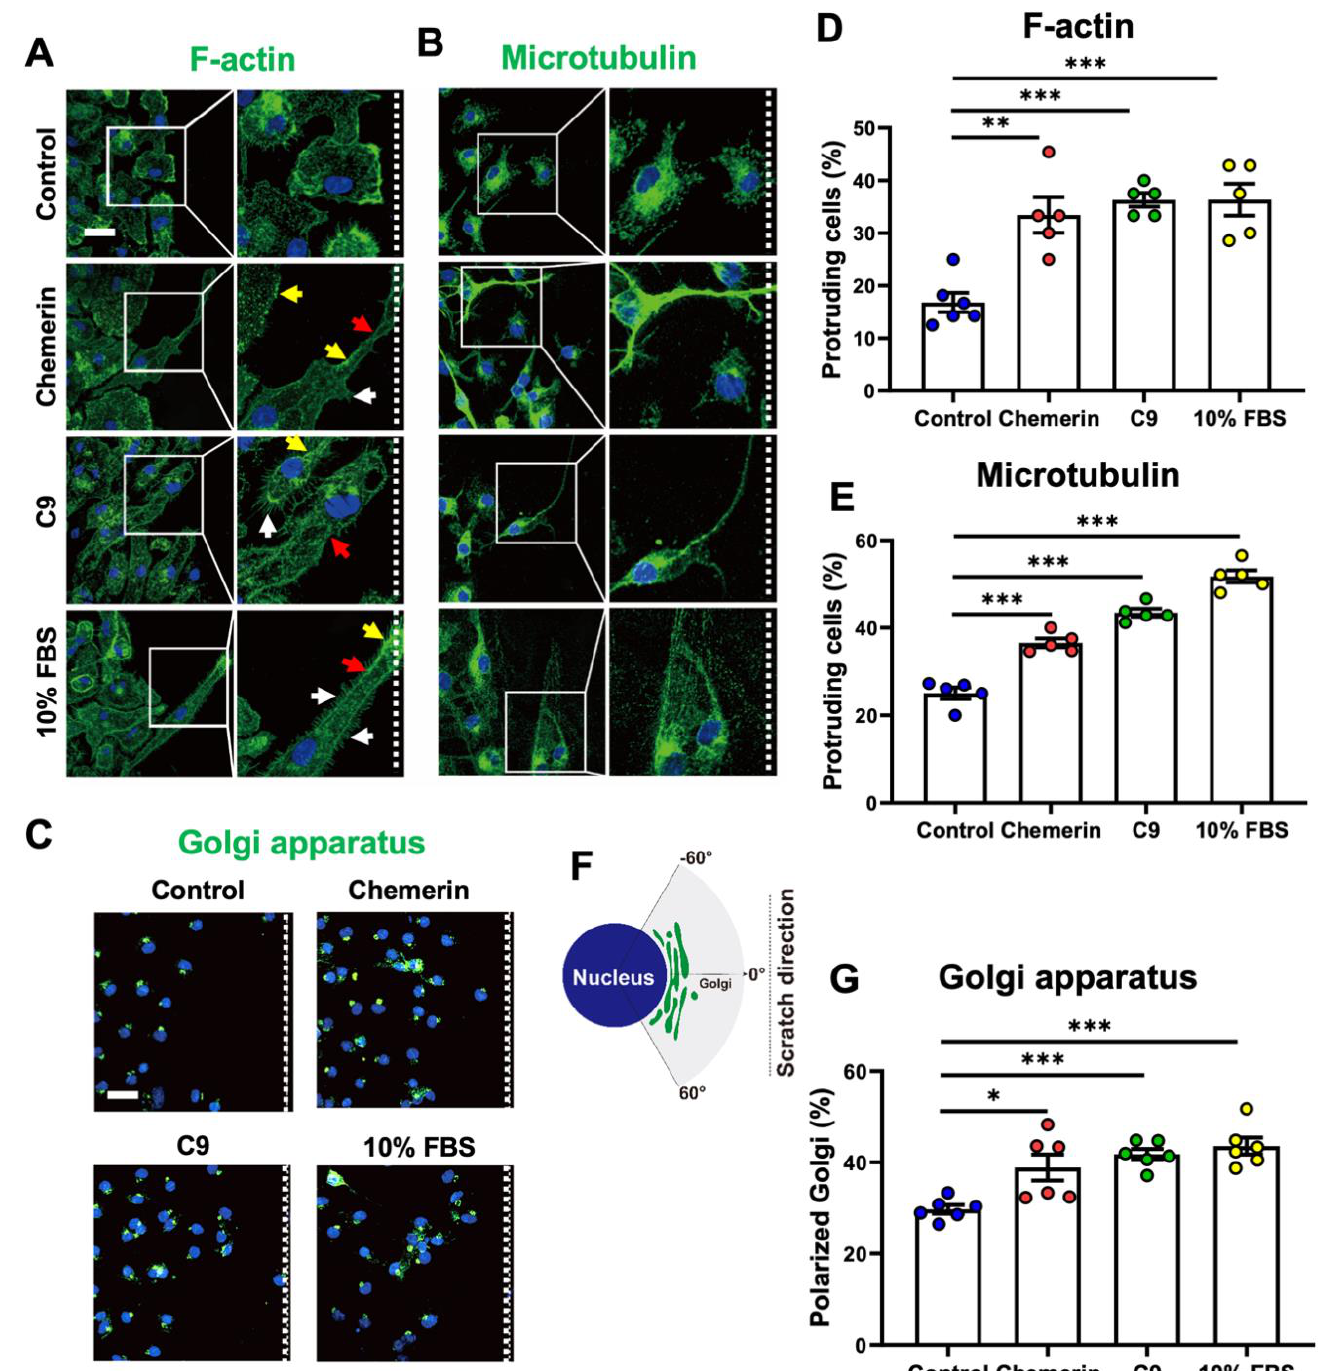
Figure 4. Chemerin promotes remodeling of actin filaments and microtubules, and reorientation of Golgi apparatus in microglia with scratch-wound assay. ( A , B ) Primary cultures of microglia were incubated with chemerin (5 nM), C9 (100 nM), or 10% FBS for scratch-wound assay. At 16 h after scratching, microglia were stained with anti-FITC-phalloidin (F-actin, green fluorescence) or anti- α -tubulin (Microtubule) polyclonal antibody and further treated with Alexa Fluor 488-conjugated anti-rabbit IgG (green fluorescence). The morphological changes in microglia could be identified: long protrusions (red arrow), lamellipodia-like structures (yellow arrow), and filopodia-like structures (white arrow). ( E ) At 12 h after scratching, the cells were stained with anti-GM130 (Golgi apparatus) polyclonal antibody and then further treated with Alexa Fluor 488-conjugated anti-rabbit IgG (green fluorescence). The cell nuclei were stained with DAPI (blue fluorescence). The scale bar in the upper left panel is 50 μm. The white dashed lines indicate the direction of the wound. The selected areas were enlarged by four times. ( C , D ) For F-actin and microtubule staining, primary microglia were scored as protruding when their protrusions were at least 4 times longer than wide. ( F , G ) For Golgi apparatus staining, the percentage of primary microglia with the Golgi apparatus in the forward-facing 120° sectors toward the wound center was measured in wound-edge cells. The results are expressed as the mean ± SEM from three separate experiments, each in at least triplicate. * p < 0.05, ** p < 0.01, *** p < 0.001.